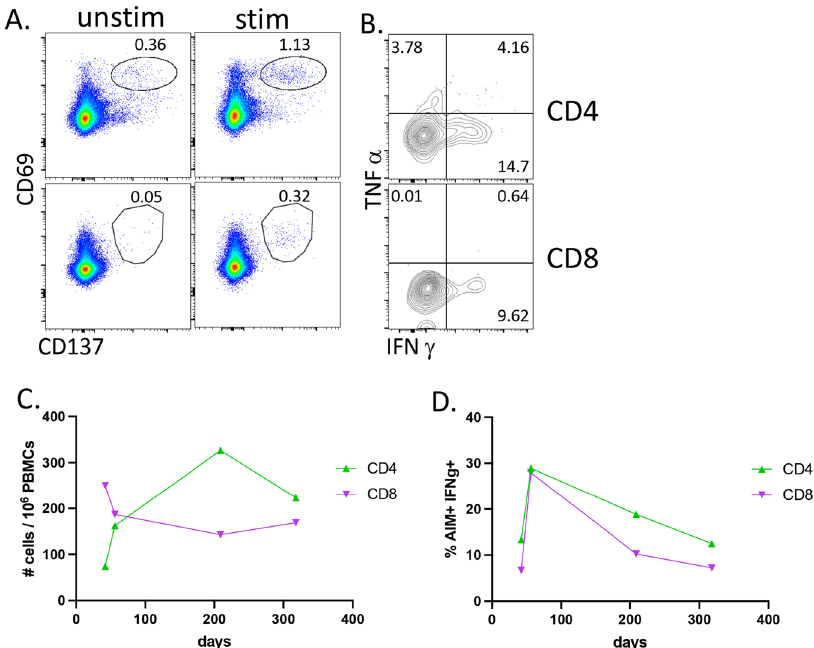
Fig. 5 Longitudinal analysis of T cell responses following mRNA-1273 vaccination. PBMCs were thawed, rested overnight, then stimulated for 24 h with a peptide library of 15-mer peptides covering the entire RBD domain with 11 amino acid overlaps. For the last 5 h, brefeldin A was added. Cells were then washed, surface stained, fi xed, permeabilized, and stained for intracellular cytokines. A T cells at 56 days post vaccination analyzed by fl ow cytometry for CD69 × CD137 double-positive cells within all live, CD19-, non-naïve (CCR7-), CD4 (top row), or CD8 (bottom row) events. Numbers above gate re fl ect the percentage of total non-naïve CD4 or CD8 events. B Intracellular cytokine staining of the cells shown on A . C quanti fi cation of events as shown in A over time and calculated as # of CD69 + × CD137 + cells per 1 million PBMCs. D Quanti fi cation of AIM + IFN γ + events as shown in B over